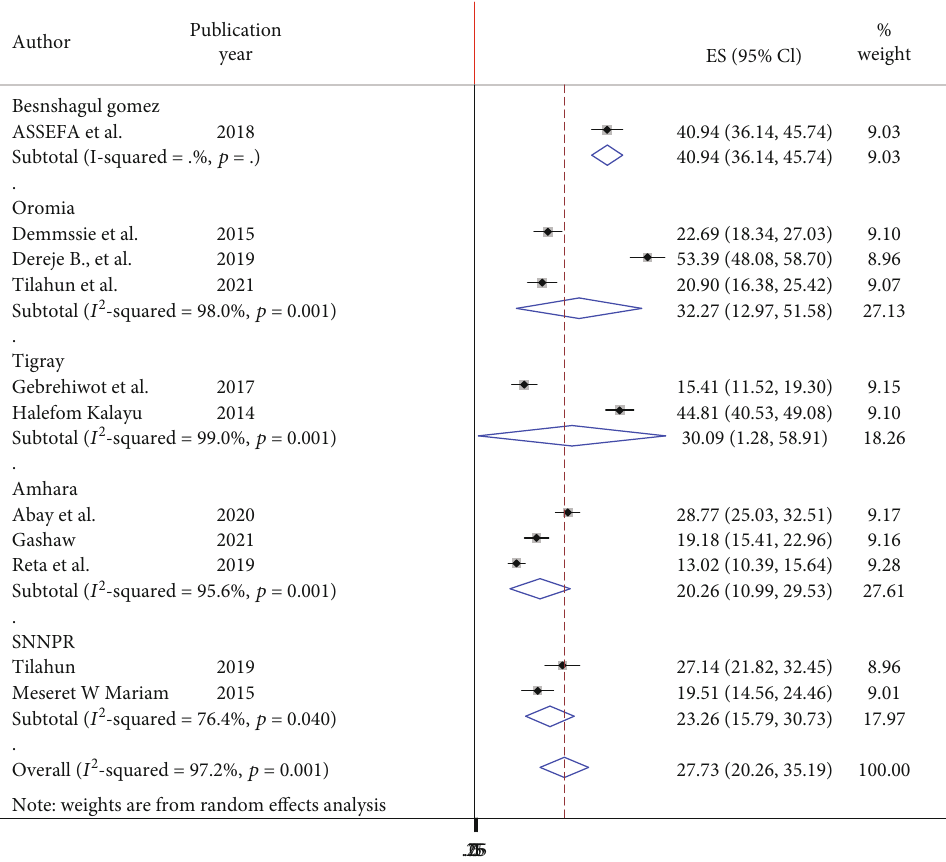
Figure 3: Forest plot showing the subgroup analysis of dual contraceptive in Ethiopia by region.